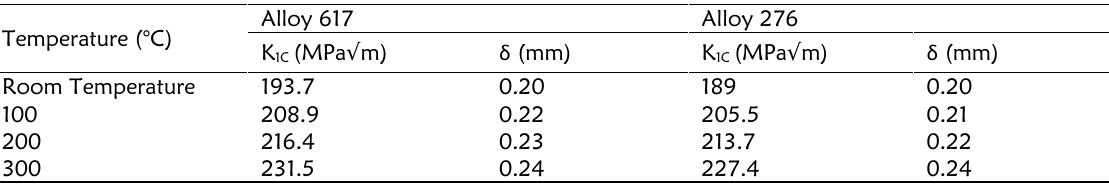
Table 3: K 1C and δ Values vs.